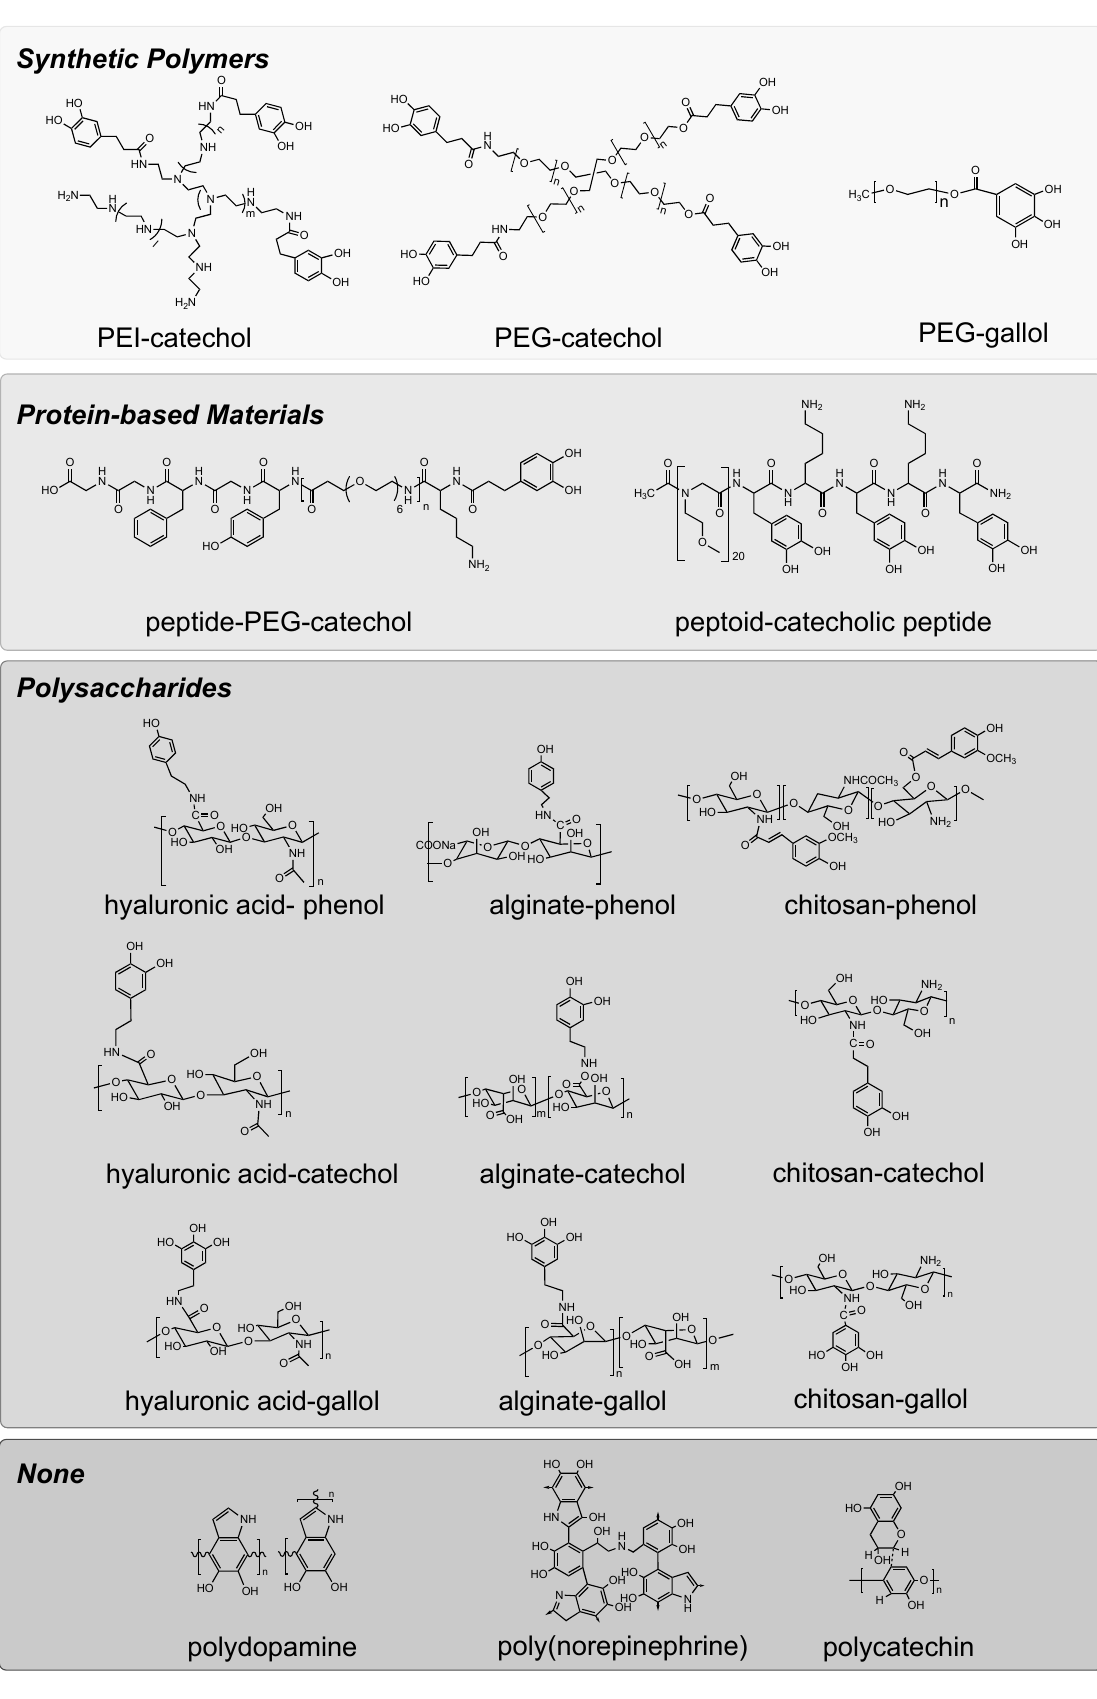
Figure 1. Schematic of representative polyphenolic materials.